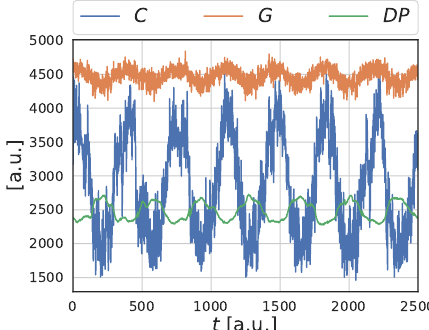
Figure 5. Real Data: raw signal example. Signals from different modules are not aligned in time and have different scales.